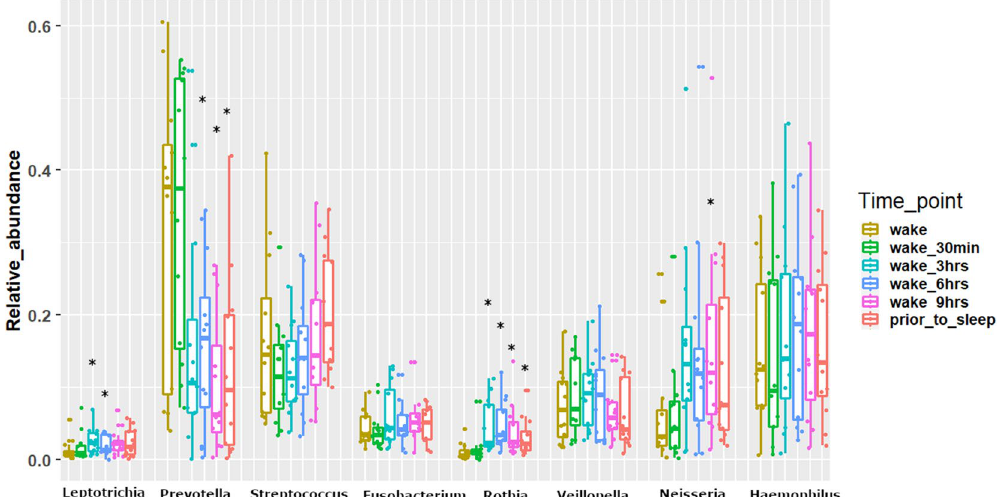
Figure 5. Taxonomic summary of relative abundance based on genera abundance. X-axis represents the major bacterial genera observed here while Y-axis represents the corresponding relative abundances. For each genus, six plots have been made and each box represents a time point. Each boxplot has been made based on the relative abundance of the genus for the 12 subjects. Mann–Whitney test was used to determine if the relative abundances of any genus differ across the time-points (represented by color of each boxplot) with reference to the ‘wake’. Asterisks over a boxplot denote significant difference (increase or decrease) in relative genus abundance in comparison to ‘wake’ time